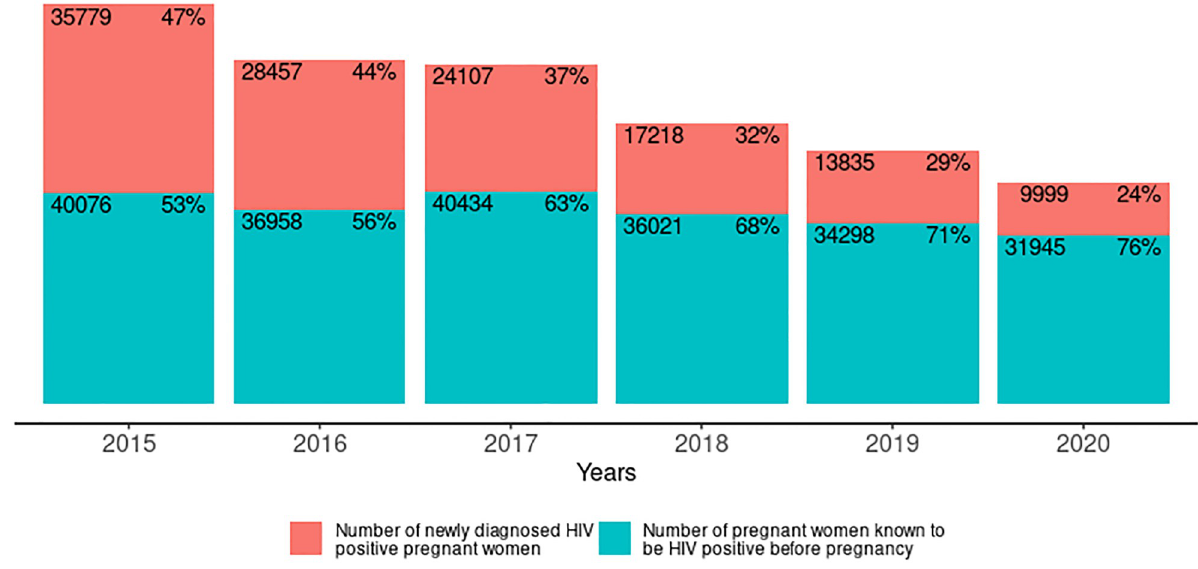
Fig 7. Number of HIV positive pregnant women identified annually disaggregated by new diagnosis and known positive from 2015–2020.